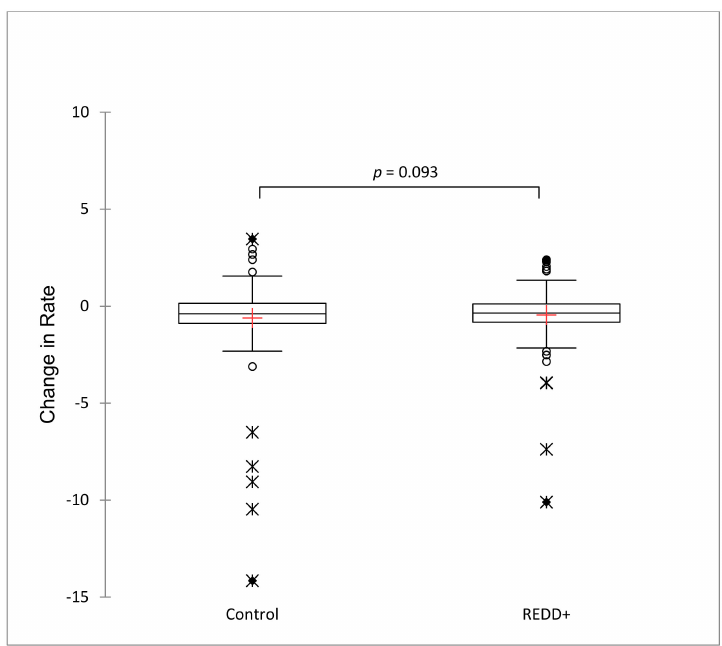
Figure 7. Boxplots and Mann–Whitney U two-sample comparison of change in annual forest cover loss after REDD + implementation (2010–2018) in matched control communities (ejidos) derived from propensity score matching (0) and treated or REDD + -intervened municipalities